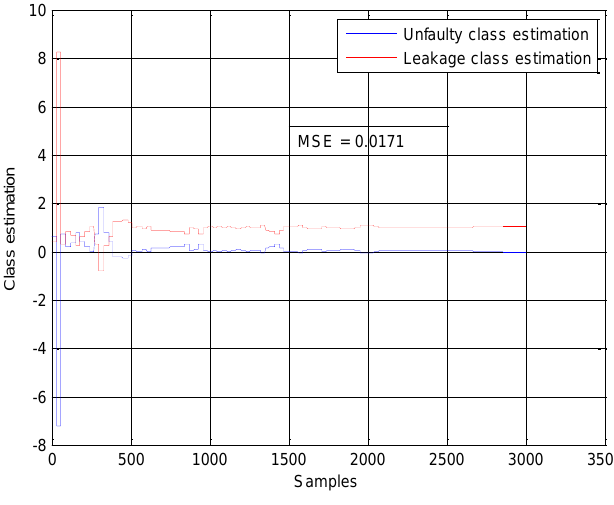
Figure 6. Engine_speed = 1000 rpm and torque = 130 Nm.